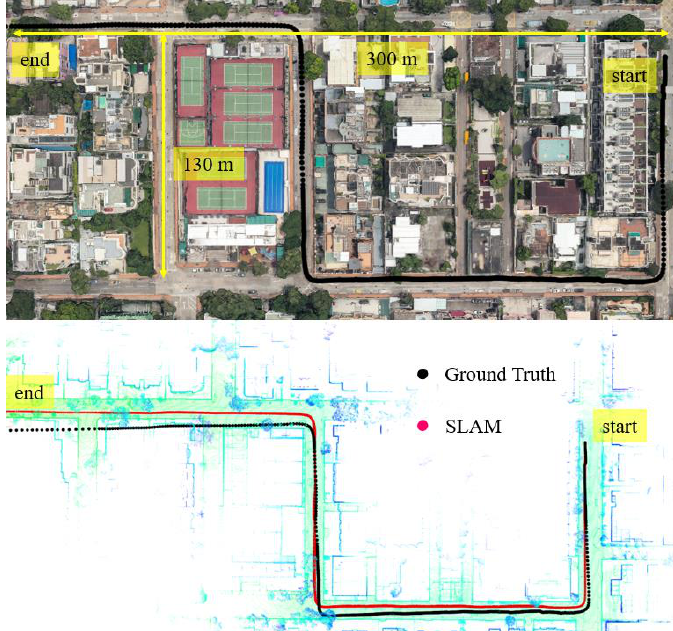
Figure 6. Experiment 1: the trajectory of NDT-based graph SLAM in a sparse area with normal traffic condition. Top panel represents the snapshot in Google Maps. The black curve indicates the ground truth of the vehicle’s trajectory. The bottom panel indicates the generated points map and trajectory from SLAM and ground truth.